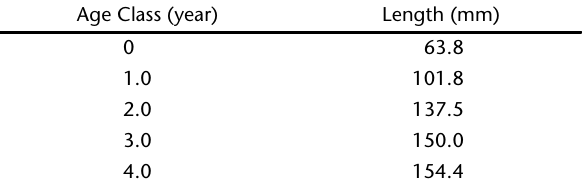
Table IV. Ages and respective values of lengths calculated from the growth equation obtained for C. edentulus in the Saco dos Limões bight (southern